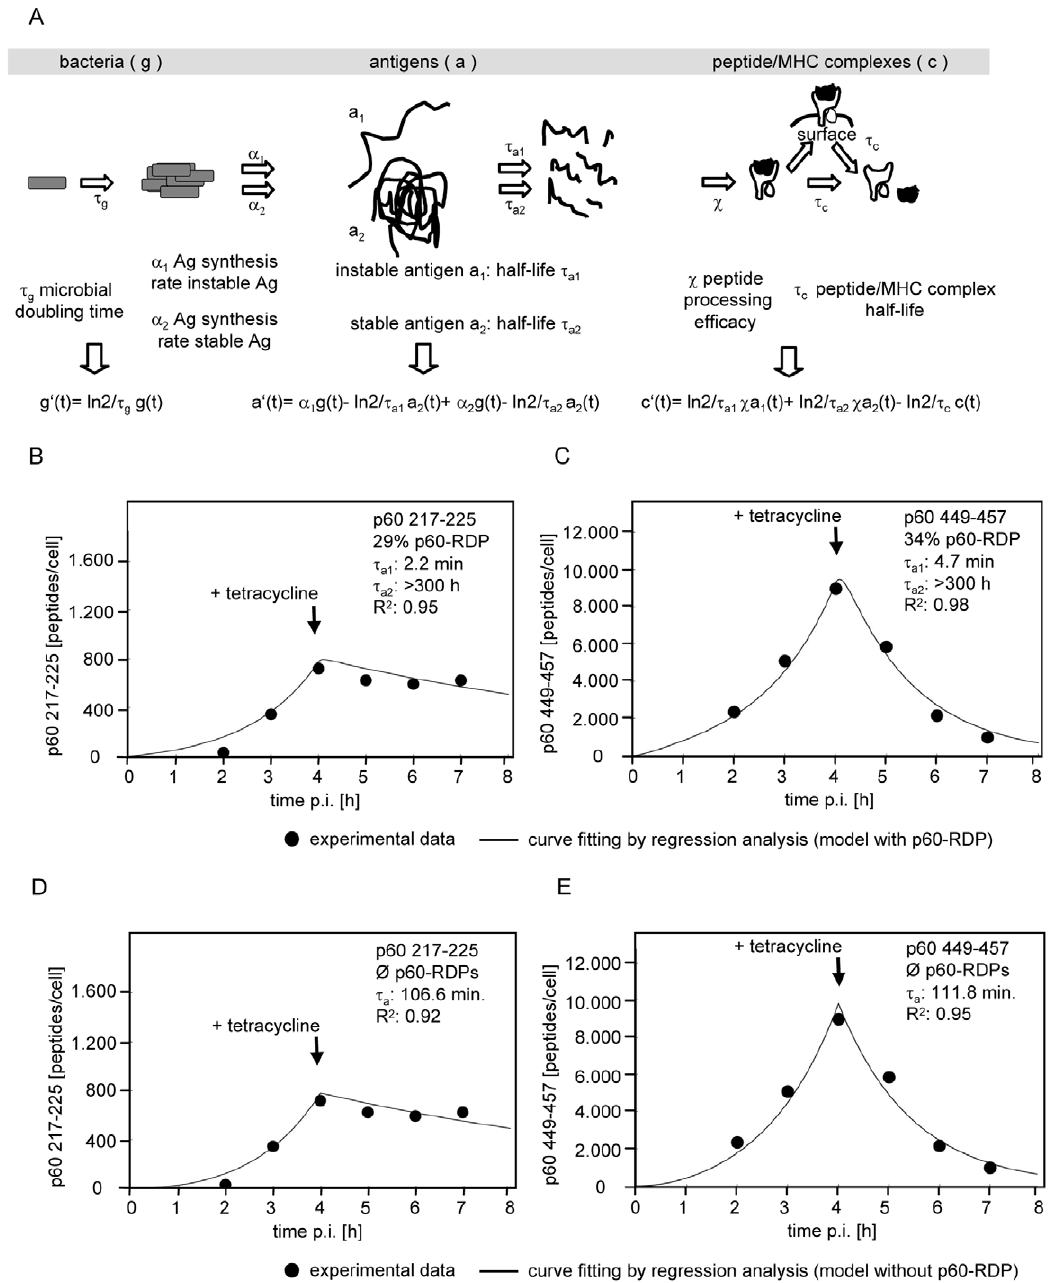
Figure 1. Mathematical modelling of p60 antigen processing. A. The interdependency of bacterial replication, antigen synthesis, antigen decay, processing of antigenic peptides, and the decay of peptide/MHC complexes is represented as a system of ordinary differential equations. The model assumes the existence of two states of an antigen that are synthesized with individual rates a 1 and a 2 and decay with different intracellular half-life t a1 and t a2 . The differential equations were solved for distinct physiological scenarios defined by the bacterial doubling time t g , the antigen synthesis rate a , and the antigen half-life t a (see supporting information: appendix S1). B–E. In order to model infected cells that were treated with tetracycline after 4 h of active bacterial replication the appropriate equations for t , 4 h and t . 4 h were merged to yield a stepwise function. This stepwise function was fitted to experimental data by non-linear regression analysis. Experimental data (filled circles) of the numbers of p60 217–225 (B, D) and p60 449–457 (C, E) peptides per cell at different time points after infection of cells with L. monocytogenes were taken from Sijts and Pamer 1997 [11]. In the experimental protocol after an initial period of 4 h of unrestricted bacterial replication and protein synthesis protein translation was inhibited by addition of tetracycline. Curve fitting was either performed on the basis of the above model assuming the presence of p60-RDP and assuming that previously accumulated p60 molecules are further processed and presented after inhibition of bacterial protein synthesis by tetracycline (B, C). Alternatively curve fitting was performed with a model without p60-RDP assuming that after inhibition of bacterial protein synthesis by tetracycline further antigen processing and presentation is blocked (D, E). Indicated are the results of curve fitting: the percentage of short-lived p60 molecules (p60-RDP) and the half-lifes of short-lived p60-RDP ( t a1 ) and long-lived p60 ( t a2 ), and the coefficient of determination (R 2 ) of the curve fitting.